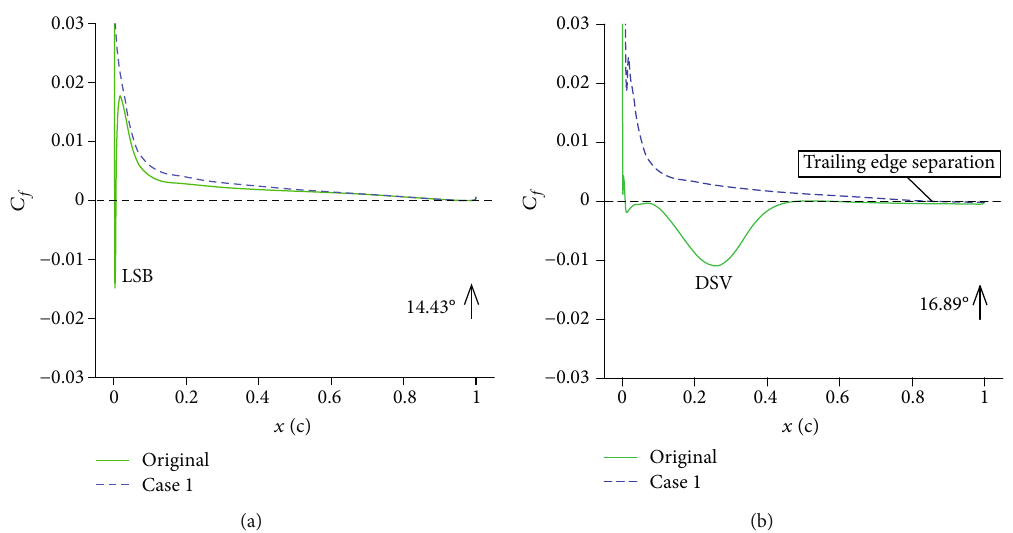
Figure 17: Skin friction coe ffi cient distributions on the airfoil upper surface at di ff erent angles of attack.